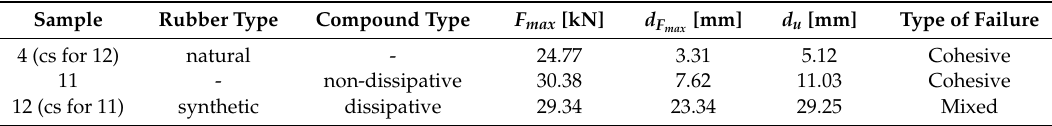
Table 7. Experimental results for samples 4, 11 and